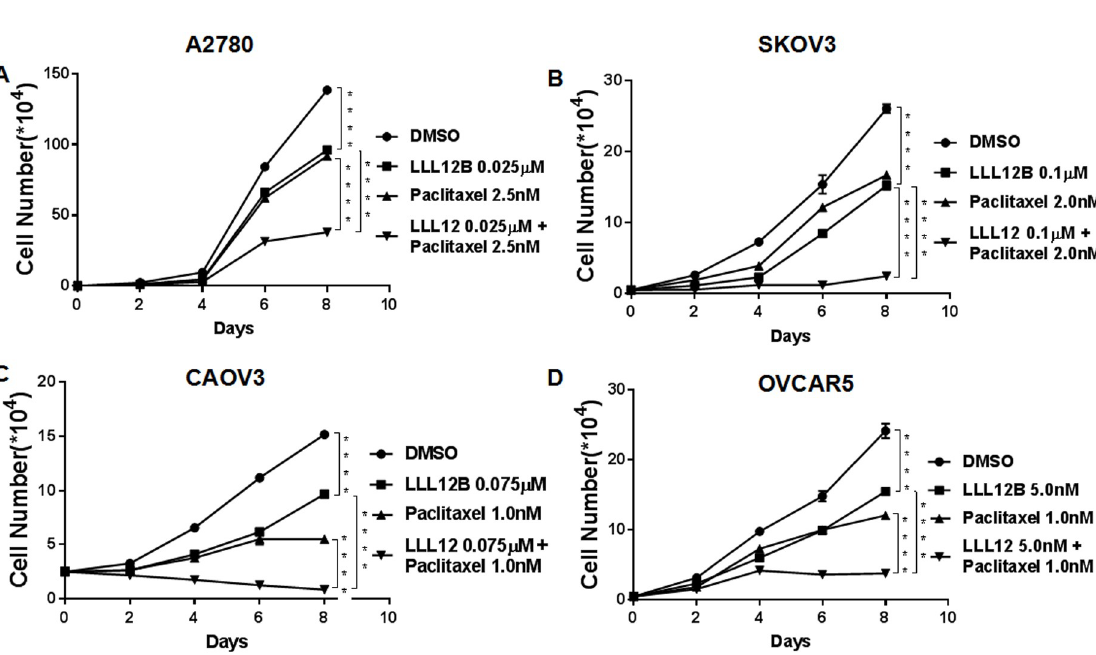
Fig 6. The effects of LLL12B, paclitaxel, and drug combination on cancer cell growth. Cell growth assays were performed to evaluate cell proliferation ability of ovarian cancer cells. Cells were treated with LLL12B, paclitaxel and their combination. The differences were found to be significantly different at �� p < 0.01 and ���� p < 0.0001. LLL12B alone or combined with paclitaxel inhibited cell growth of ovarian cancer cells.